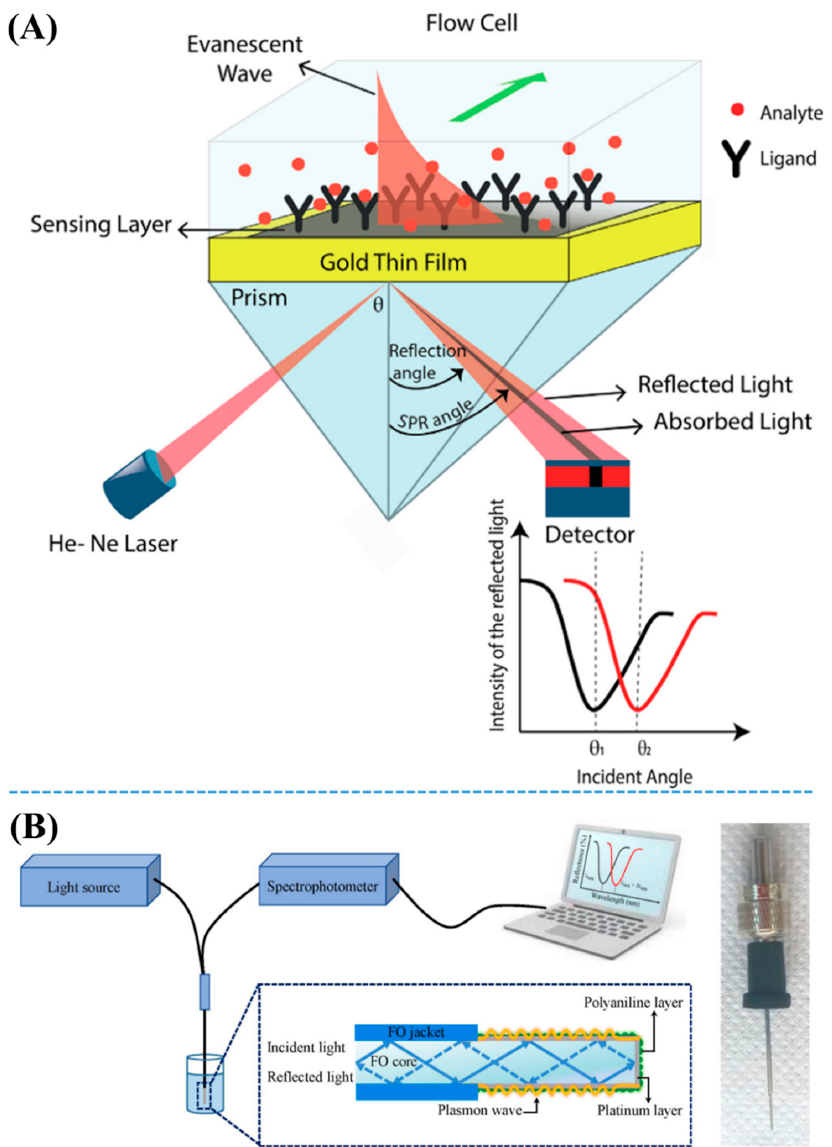
Figure 6. ( A ) Schematic diagram of dopamine detection using composites of chitosan/graphene quantum dots/Au thin film by means of SPR spectroscopy. Reproduced with permission from [93]. ( B ) Schematic diagram of 4-nitrophenol detection using innovative polyaniline/Pt-coated fiber optic-based SPR sensing substrate. Adapted from [23].